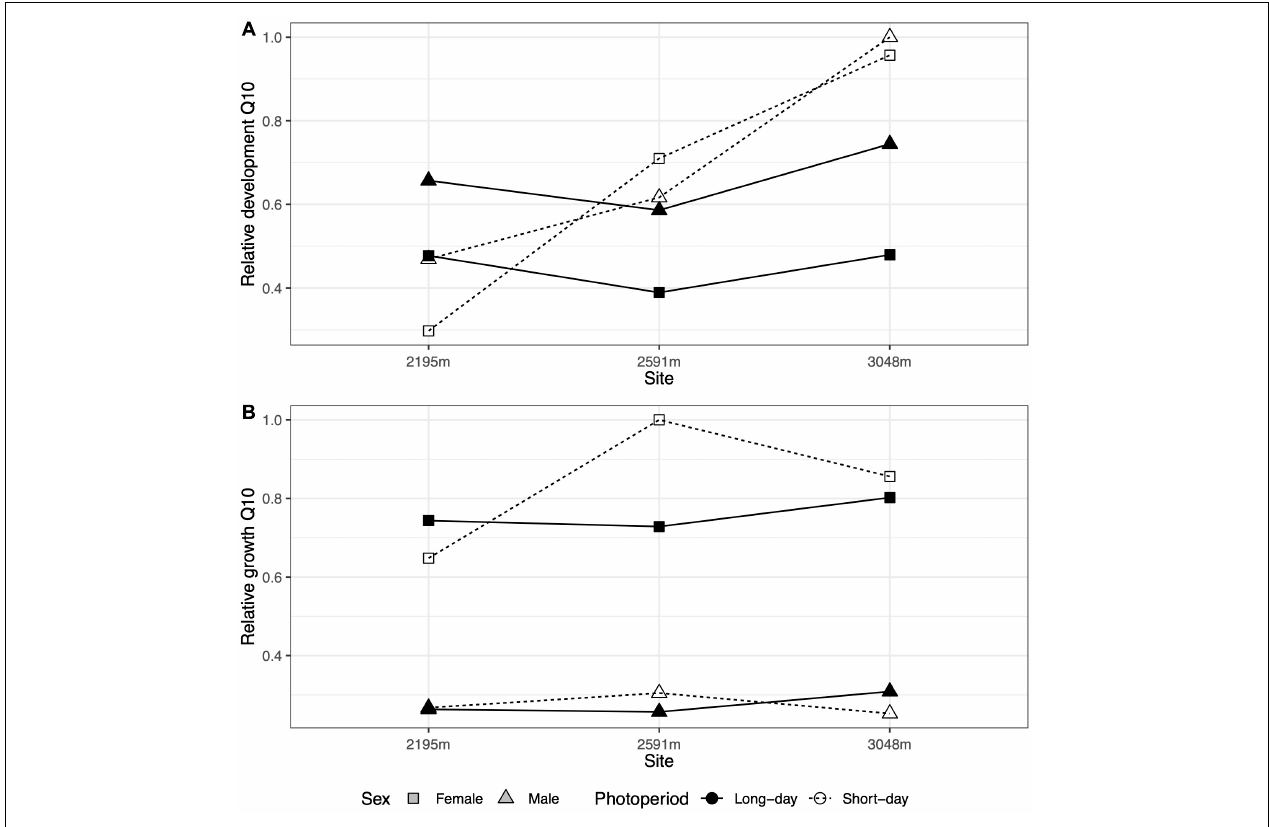
FIGURE 2 | (A) The relative thermal sensitivity (Q10) of development (normalized from 0 to 1) is relatively flat across site elevations for long-day conditions (filled symbols and solid lines) but increases with elevation for short-day conditions (open symbols and dashed lines) for both sexes (symbols). (B) The relative thermal sensitivity (Q10) of growth does not vary consistently with